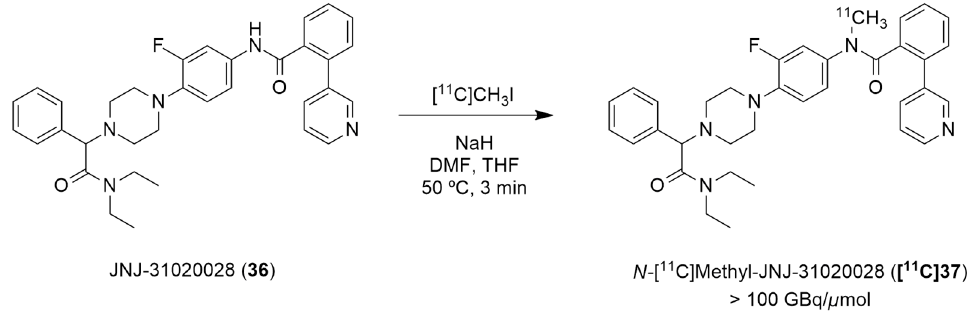
Figure 11 . Radiosynthesis of N-[ 11 C]methyl-JNJ-31020028 ( [ 11 C]37 ). Figure 11. Radiosynthesis of N-[ 11 C]methyl-JNJ-31020028 ( [ 11 C]37